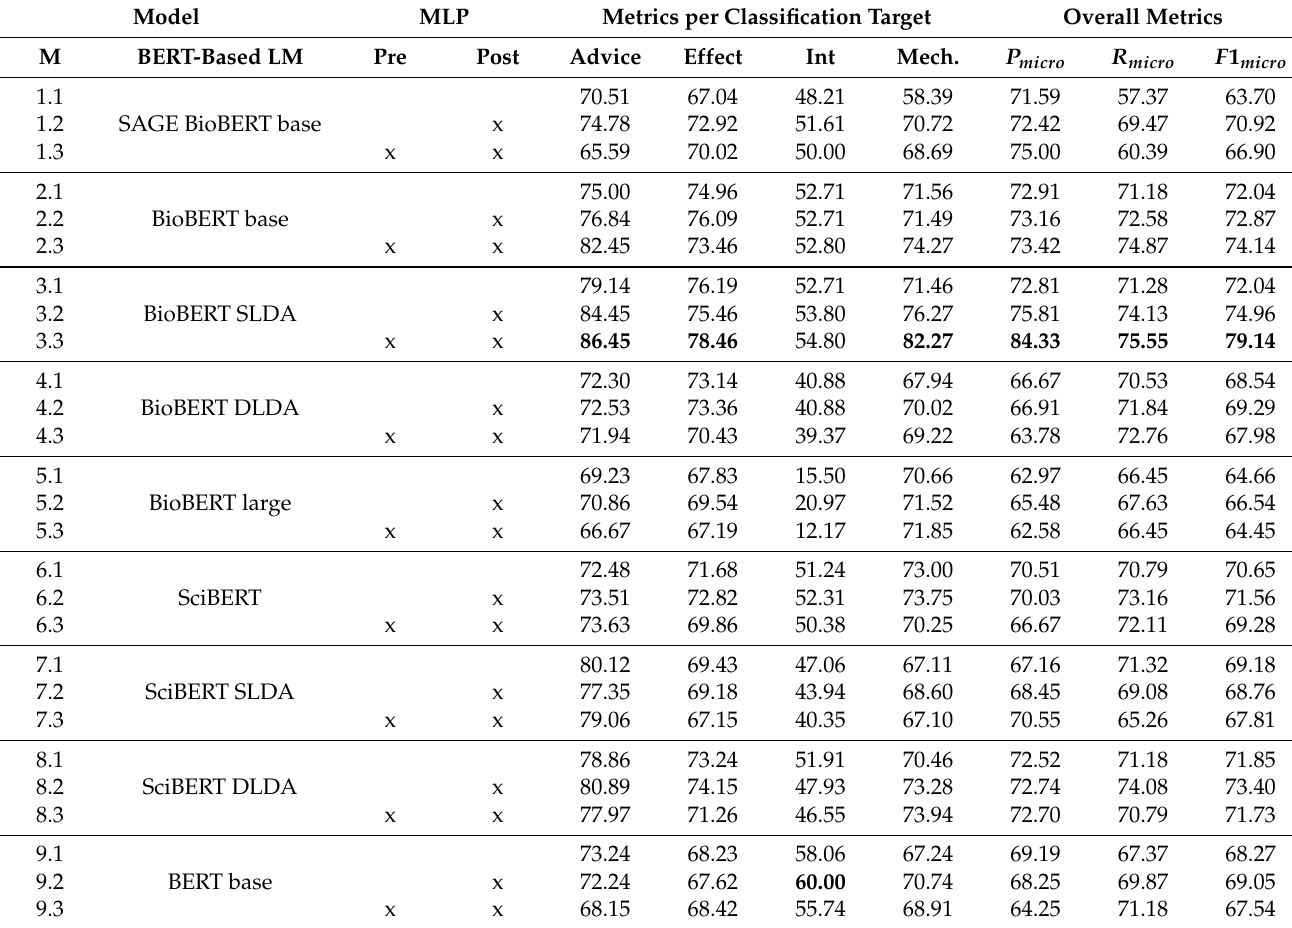
Table 3. Performance comparison of the pre-trained LM. SAGE denotes the models that utilize the GraphSAGE framework. SLDA and DLDA denote the Sentence and Document Level Domain Adaption, respectively, and x denotes the inclusion of the corresponding pre/post-processing MLP unit. The highest values are shown in